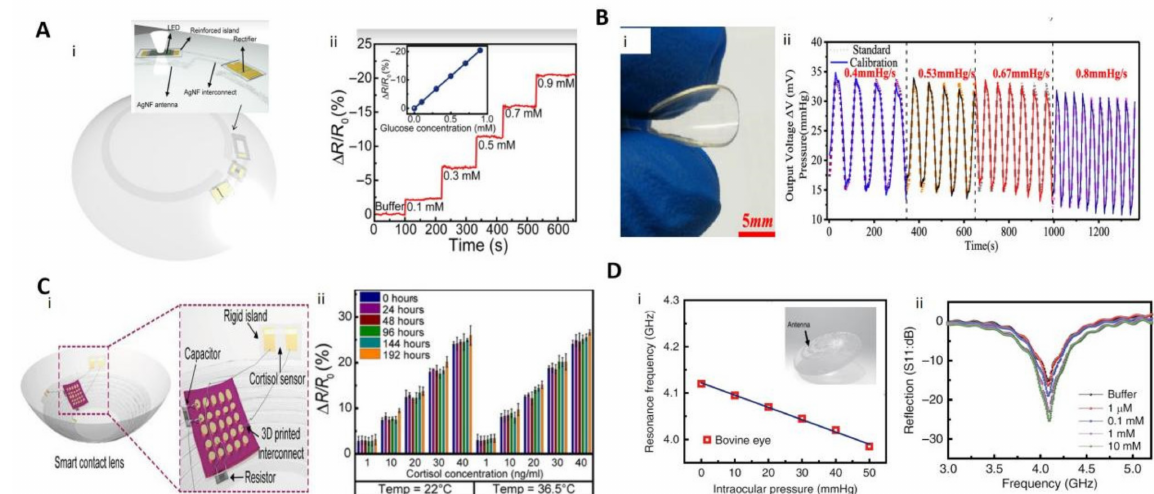
Figure 3. Several contact lens sensors based on 2D materials. ( A ): (i) Glucose contact lens sensor and schematic diagram of the structure. (ii) Variation in the resistance of the sensor in different concentrations of glucose [117]. Copyright 2018, American Association for the Advancement of Science. ( B ): (i) Optical photograph of the IOP contact lens sensor. (ii) Comparison between the calibrated IOP and the standard IOP at different speeds [118]. Copyright 2020, American Chemical Society. ( C ): (i) Cortisol contact lens sensor and schematic diagram of the structure. (ii) Variation in the resistance of the sensor at different temperature and time states [119]. Copyright 2020, American Association for the Advancement of Science. ( D ): (i) Frequency response of the intraocular pressure sensor on the bovine eye from 5mmHg to 50mmHg. Illustrations show schematic diagram of the structure of the composite contact lens sensor. (ii) Wireless monitoring of glucose concentrations from 1 µ M to 10mM [47]. Copyright 2017, Springer